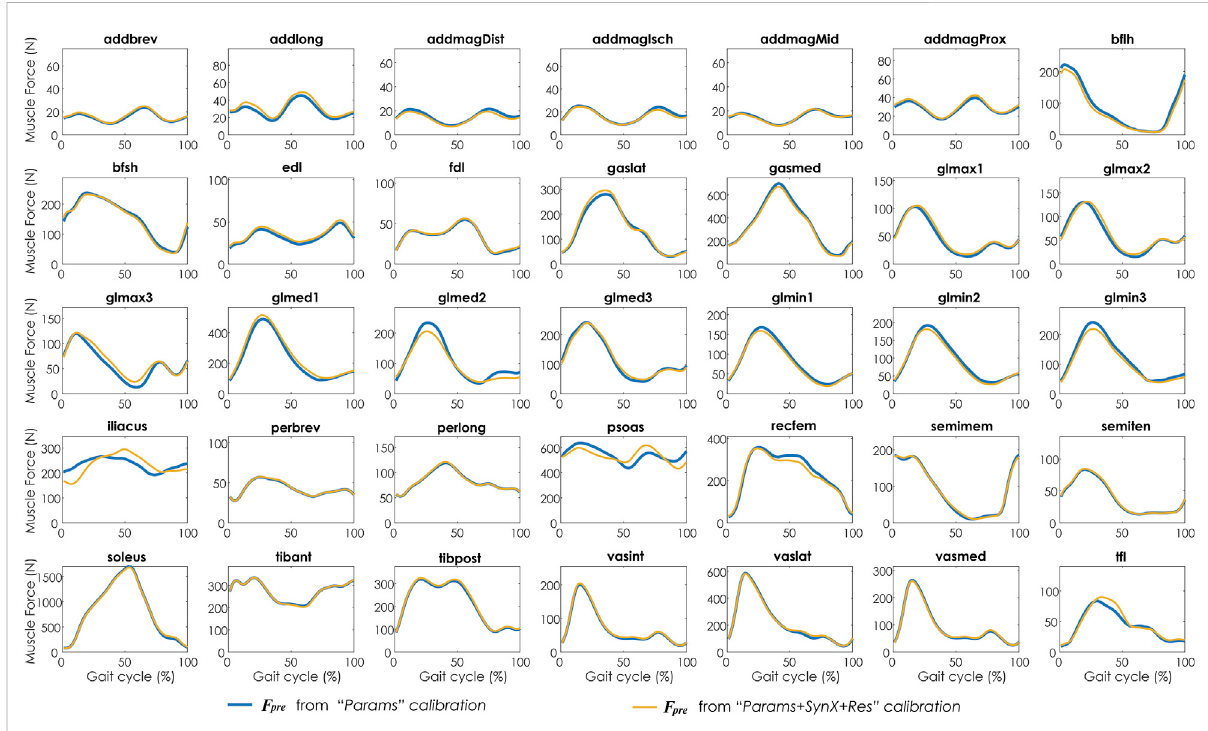
FIGURE 6 Averagemuscleforcesacrosscalibrationtrialsandsubjectsfrom “ Params ” calibration(inblue)and “ Params+SynX+Res ” calibration(inyellow). Results for “ Params + SynX + Res ” calibration were produced using the best methodological combinations for analyzing experimentally measured walking motions (trial-speci fi c unmeasured and speed-speci fi c residual synergy vector weights with six synergies). Here, residual excitations were calibrated butnot usedtocalculate muscleforcesfor “ Params+ SynX+Res. ” Dataarereported forthecompletegaitcycle,where 0%indicates initial heel-strike and 100% indicates subsequent